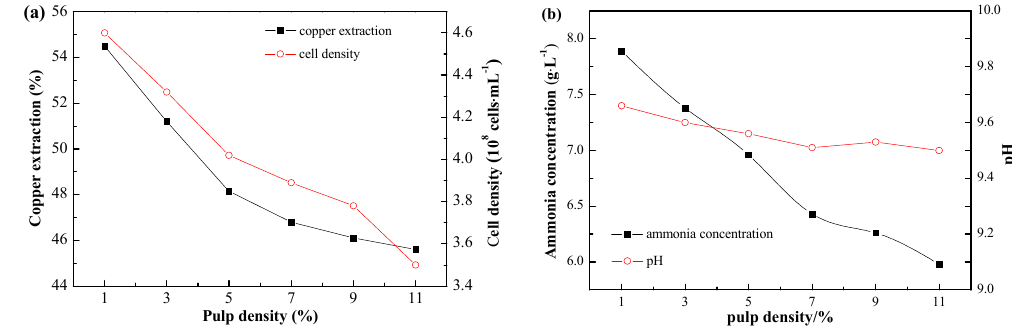
Figure 7. ( a ) Copper extraction at different pulp densities after bioleaching for 156 h. Cell densities were measured after bioleaching for 64 h; ( b ) Ammonia concentration and pH change in bioleaching system at different pulp densities. The data in the figure were measured after bioleaching for 64 h.